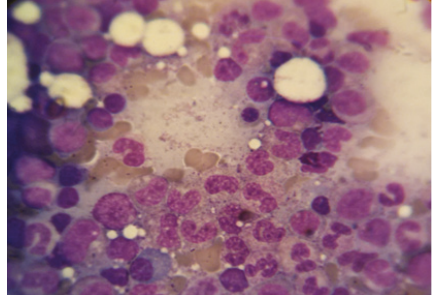
Figure 2: Karyotype analyses showed 46 XY compatible with the apparently normal male with no chromosomal aberration on the basis of GTG technique at 350–400 band resolution.